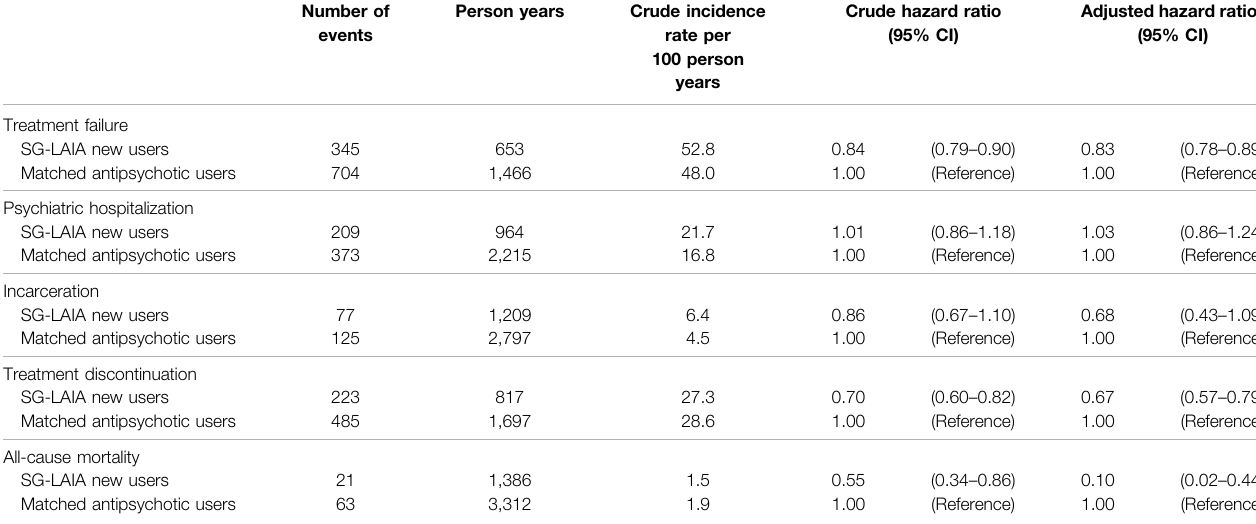
TABLE 3 | Association between second-generation long-acting injectable antipsychotic monotherapy versus oral antipsychotic monotherapy and treatment failure, psychiatric hospitalization, incarceration, treatment discontinuation, and all-cause mortality.